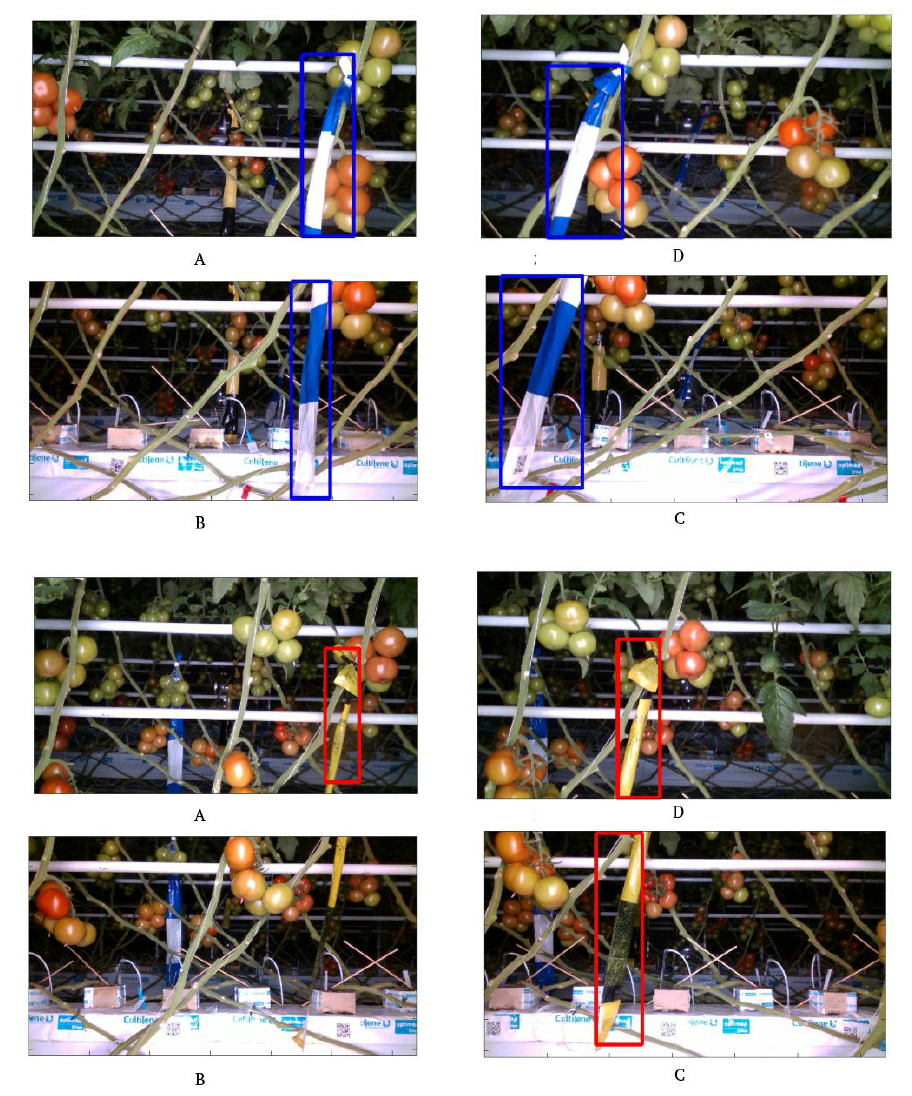
Figure 6. Plot demarcation: examples of detection of 2 ribbons in groups of neighboring images. We see that if a ribbon gets missed in one image, it can get detected in neighboring